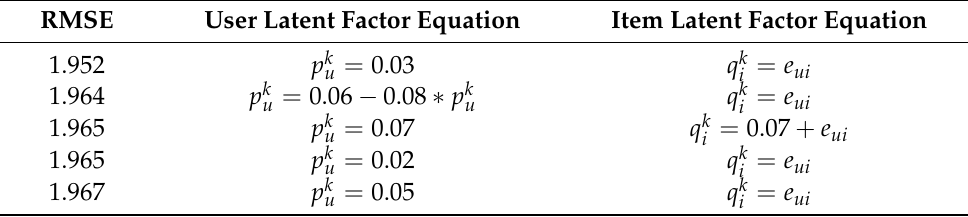
Table 10. Book-Crossing optimization